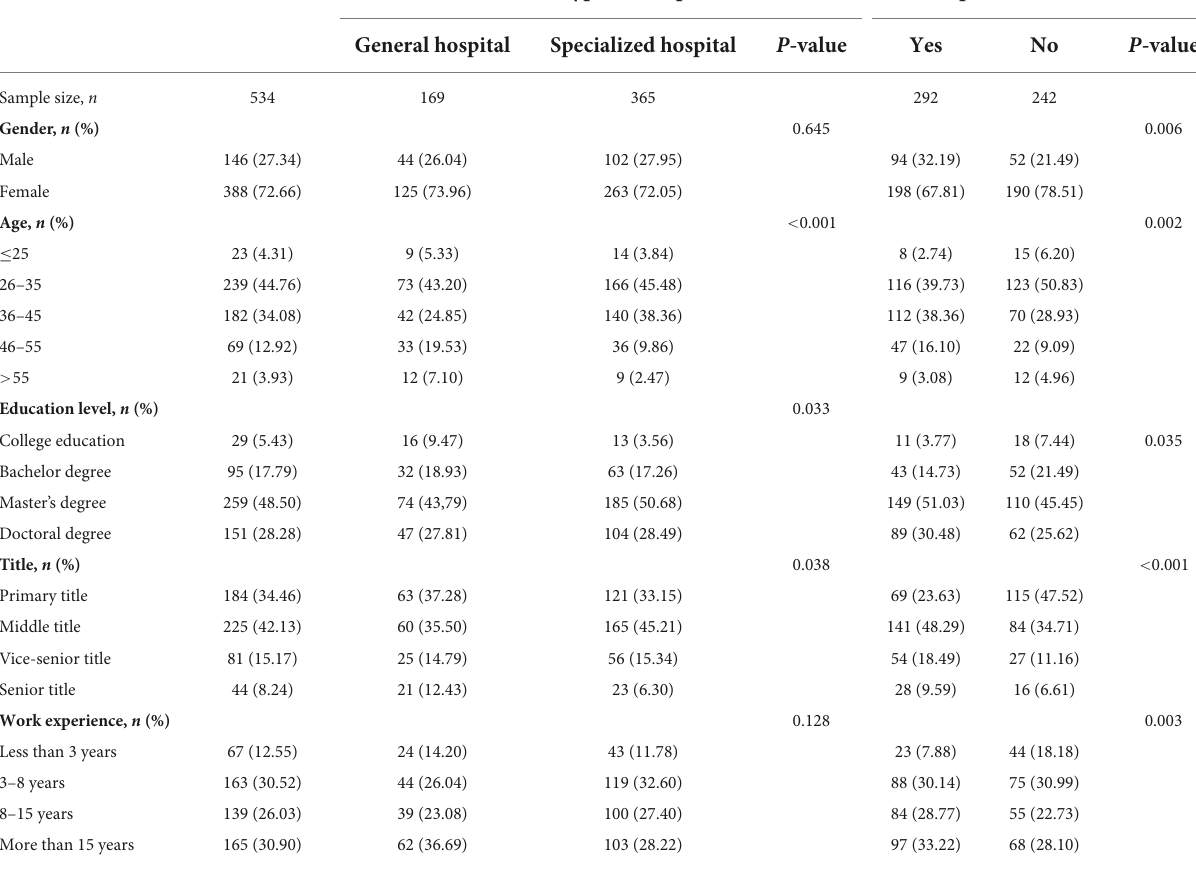
TABLE 1 Demographic characteristics of the participants ( N =